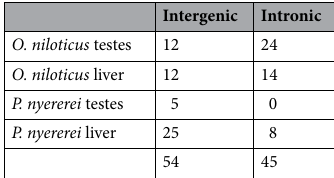
Table 1. Identification of novel ORFs. The number of unique intergenic and intronic novel species-specific translation products for each tissue and species.